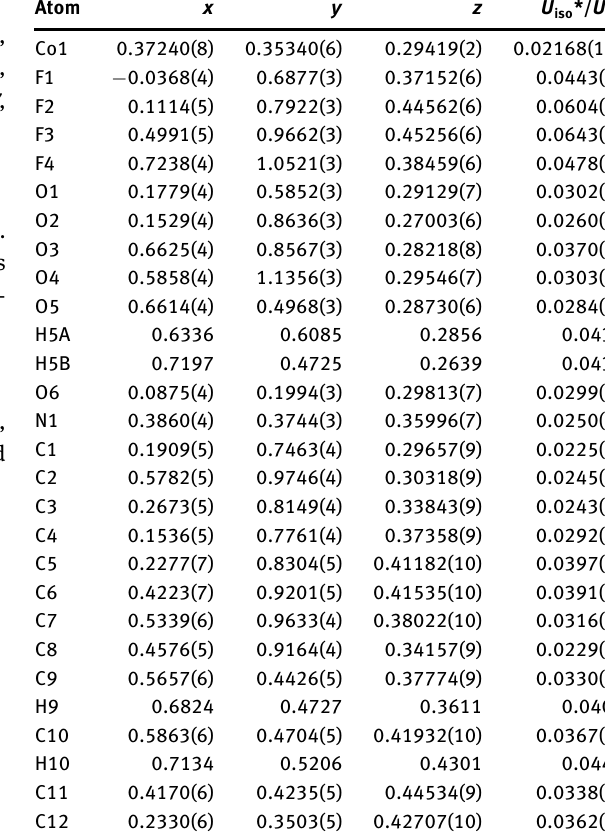
placement parameters.